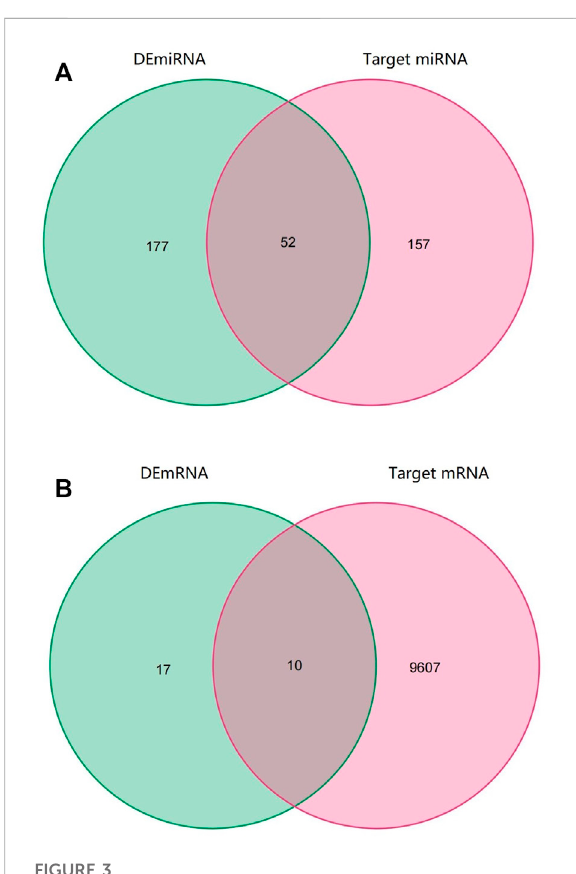
FIGURE 3 Venn diagram of RNAs involved in the ceRNA network. (A) The predicted target miRNA and DEmiRNA intersected (B) The target mRNA and DEmRNA